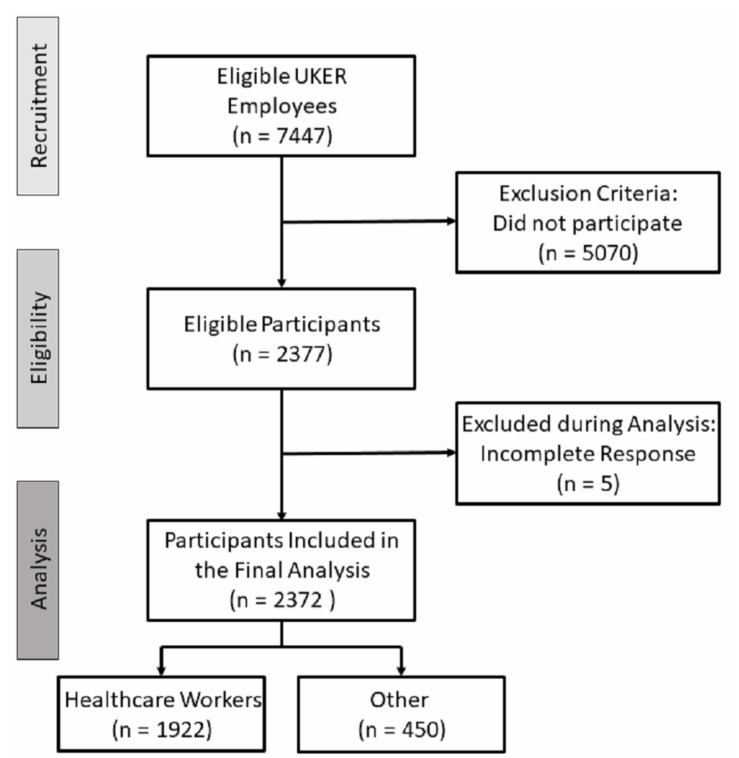
Figure 1. Flowchart of study